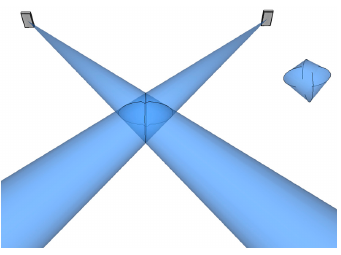
Figure 5. Illustration of uncertainty cones and the solid—common part of the two cones.